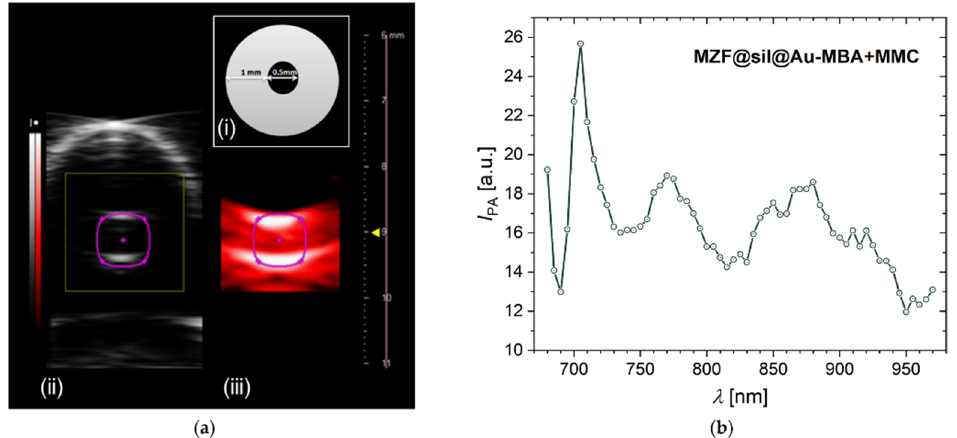
Figure 11. Photoacoustic study on the suspension of MZF@sil@Au-MBA+MMC nanoshells with a ferrite concentration of 0.64 mmol(f.u.) L − 1 . ( a ) PAI study: (i) A scheme showing the experimental setup—a cross-section of the tube filled with the suspension, (ii) an ultrasound image of the tube with the nanoshells, and (iii) a photoacoustic image of the same tube obtained at 680-nm excitation; ( b ) photoacoustic spectrum of the MZF@sil@Au-MBA+MMC nanoshells. The SERS spectra measured on aqueous suspensions of MZF@sil@Au-MBA+MMC